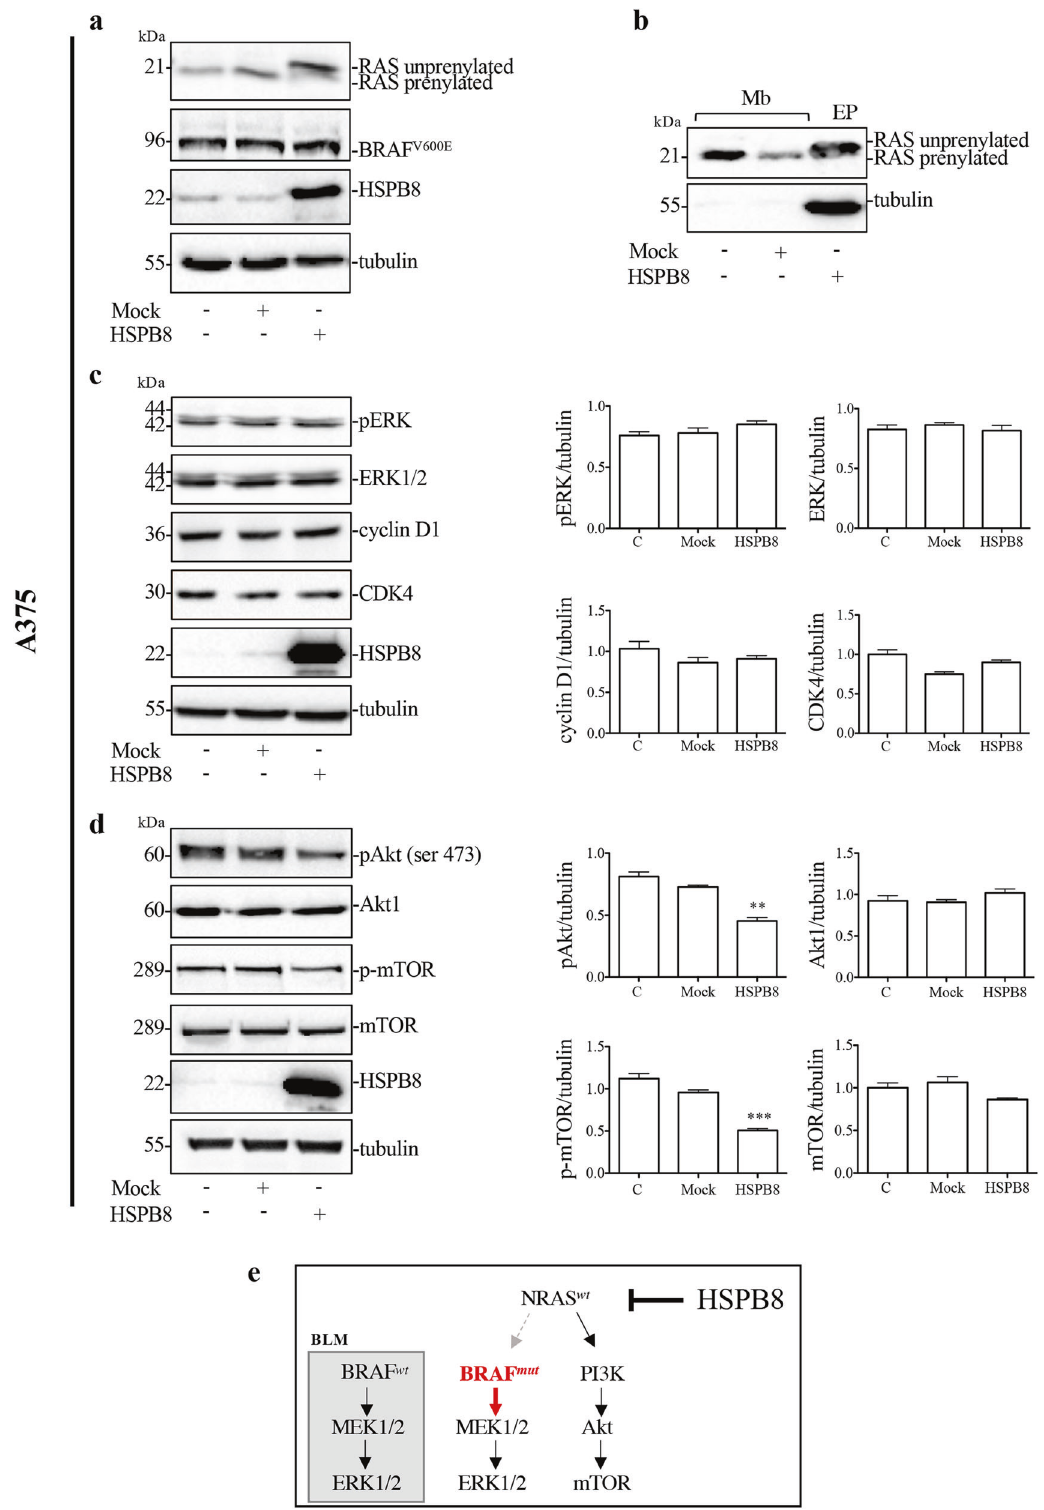
To clarify the functional relationship between autophagic activation and HSPB8-induced RAS-prenylation inhibition, we evaluated the effect of 3-MA on RAS expression demonstrating